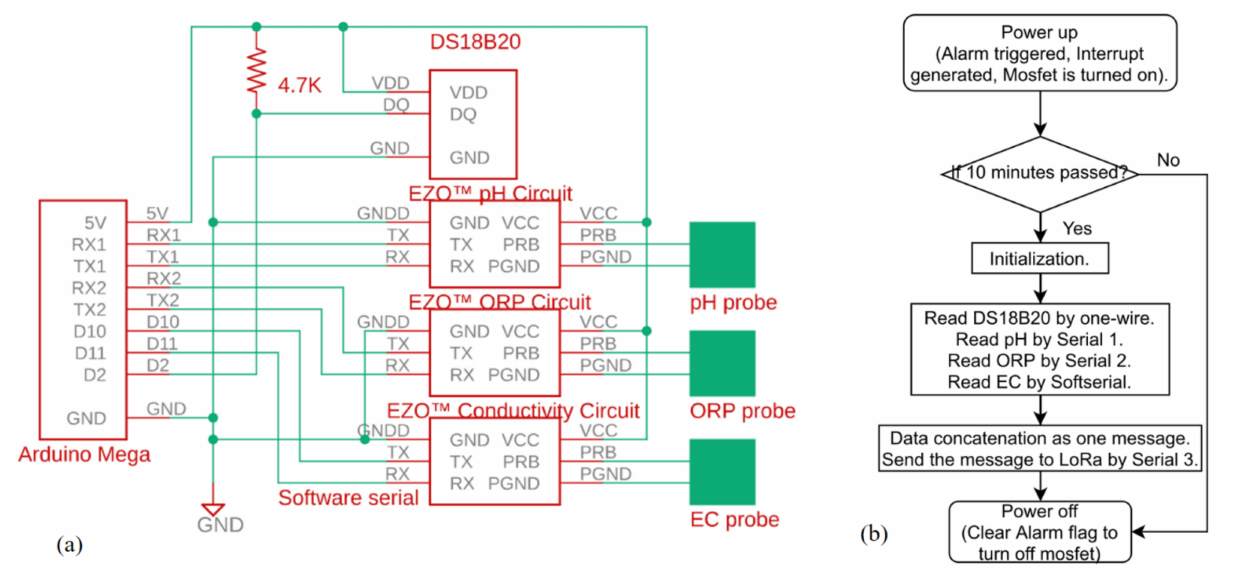
Figure 3. ( a ) A partial schematic and ( b ) a program flowchart for the type A